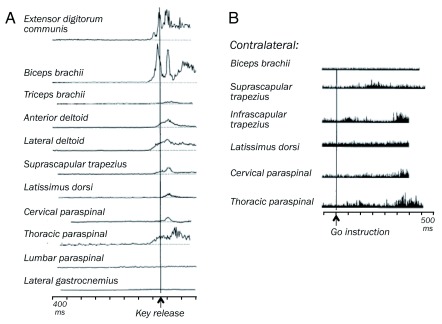
Monitoring of muscle activation during unilateral reaching in macaque monkeys(
A) Activity in forearm, upper arm, shoulder, back, and leg muscles during self-initiated arm movements (rectified electromyograms). Some midbrain dopamine neurons show slow activations before (12%) and during (16%) these movements. From Romo and Schultz
55. (
B) Activity even in contralateral muscles during instructed, stimulus-triggered arm reaching movements. From Schultz and Romo
70 with permission from Springer Nature, RightsLink License Number: 4662430242555.